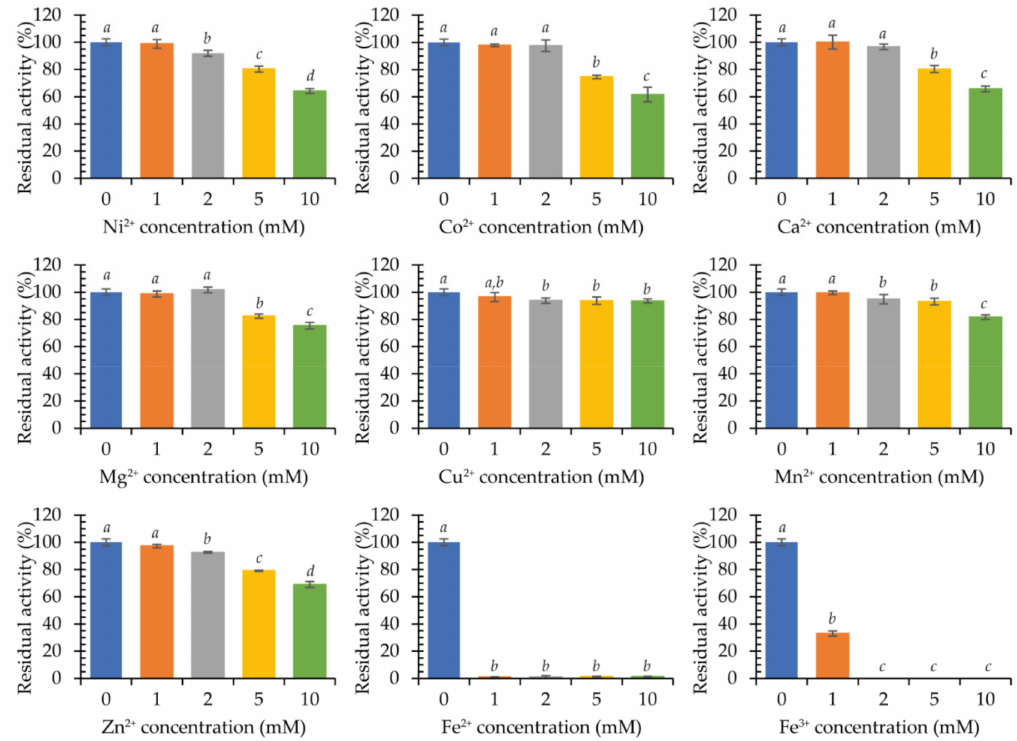
Figure 6. Activity of purified recombinant laccase KbLcc1 in the presence of various metal ions at 1 mM, 2 mM, 5 mM and 10 mM concentration in the reaction mixture; the data presented as the means ± SD from at least three independent experiments; the means that are marked with different letters ( a – d ) are significantly different ( p <